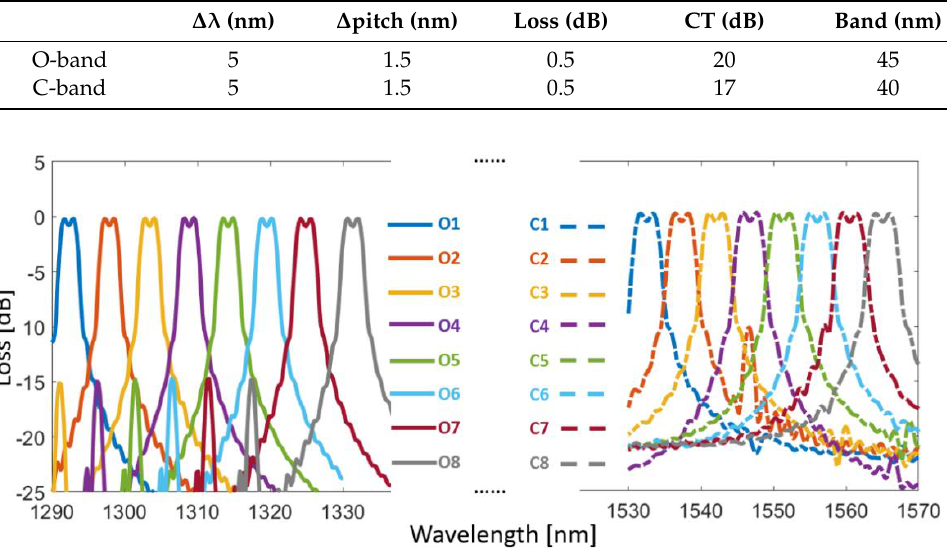
band is lower than 0.5 dB, crosstalk below 20 dB, C-band loss lower than 0.5 dB, crosstalk below 17